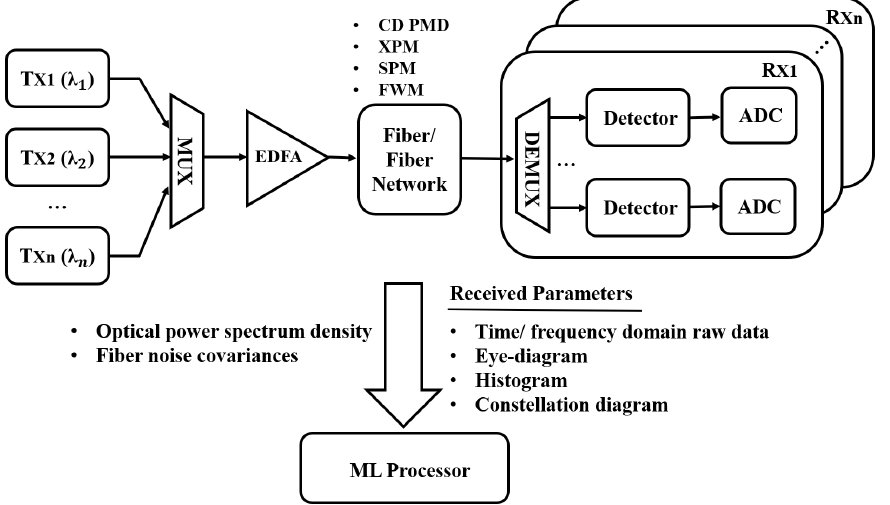
Figure 7. Typical application of ML models for MFI and OPM in short-reach optical systems and networks; MUX: multiplexer; EDFA: erbium-doped fiber amplifier; ADC: analog to digital converter XPM: cross-phase modulation; FWM: four-wave mixing; SPM: self-phase